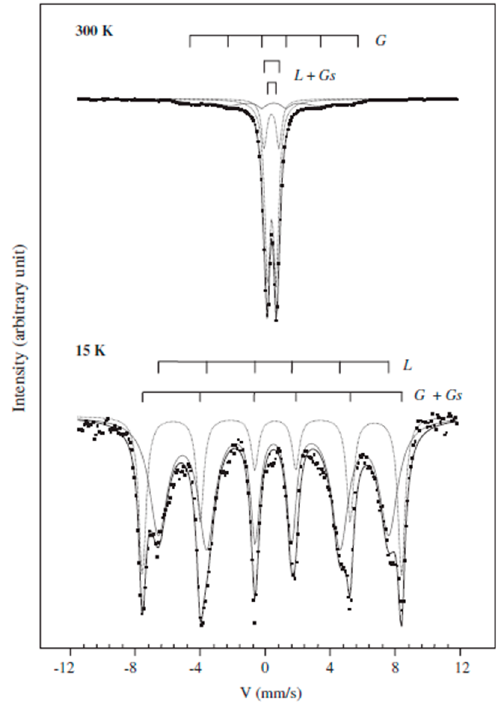
Figure 16. Mössbauer spectra measured at room and low temperature of the coating layer formed at the surface of an Ni-advanced weathering steel after marine exposure (see text). Reproduced from [41], with permission from Elsevier,